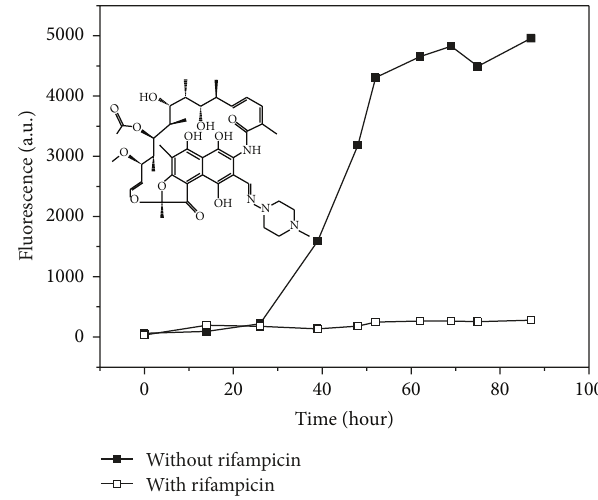
Figure 1: Effect of rifampicin on the fibrillation of HEWL by ThT fluorescence assay. Inset: molecular structure of